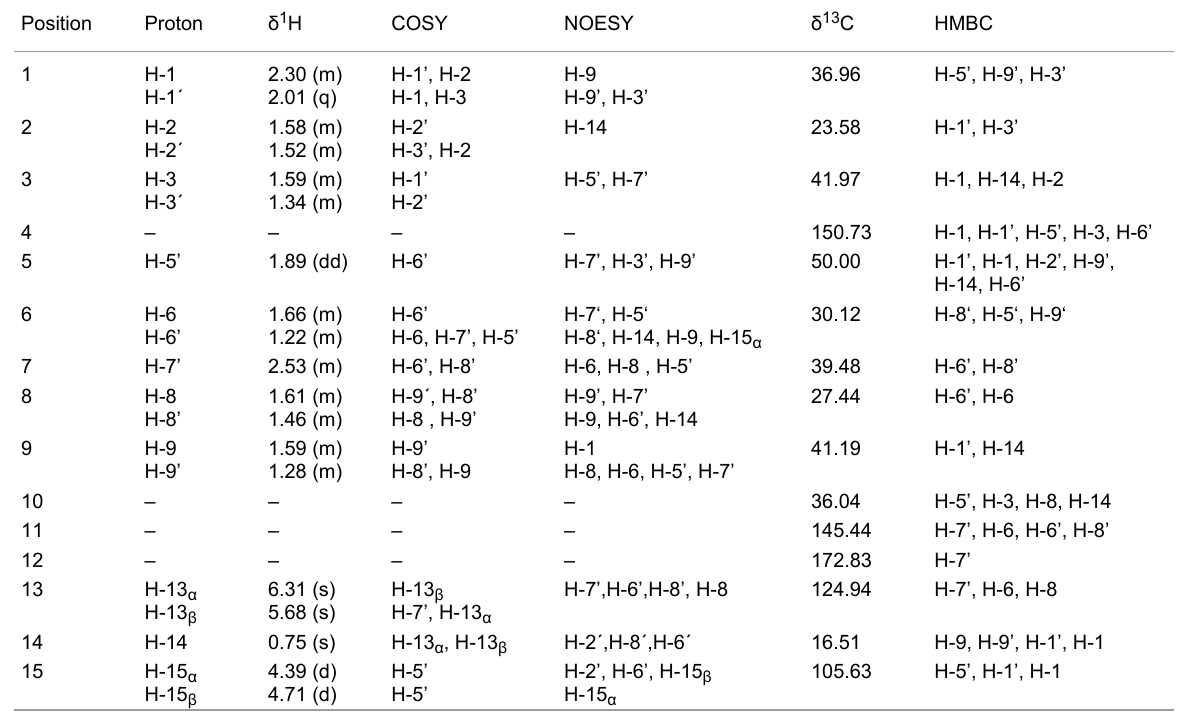
Table 1: NMR spectroscopic data of costic acid a